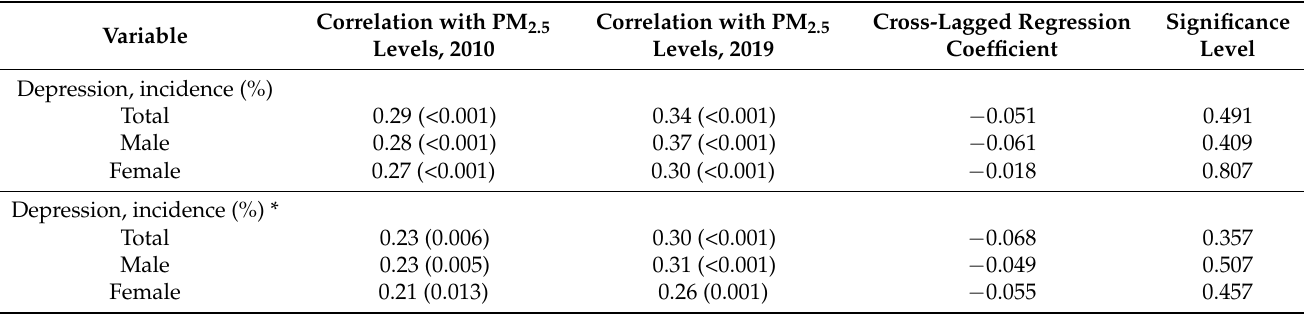
Table 4. Cross-lagged regression analyses between PM 2.5 levels and the incidence of depression for the period 2010–2019.